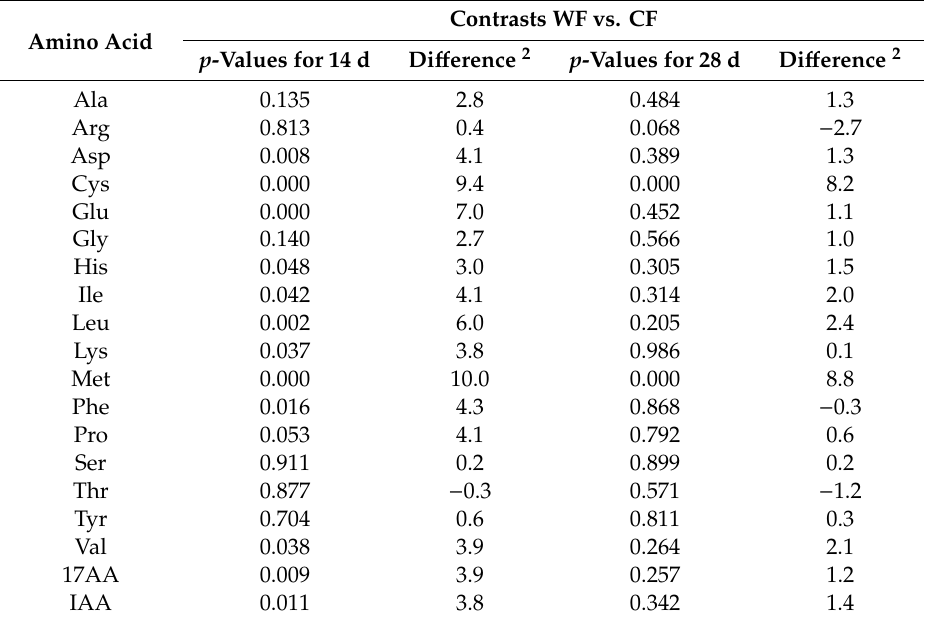
Table 5. Results of contrast testing between the standardised ileal amino acids digestibility of WF and CF peas 1 fed without protease supplementation ( n = 6) in broiler chickens at 14 or 28 days of age. Contrasts WF vs. CF Amino Acid